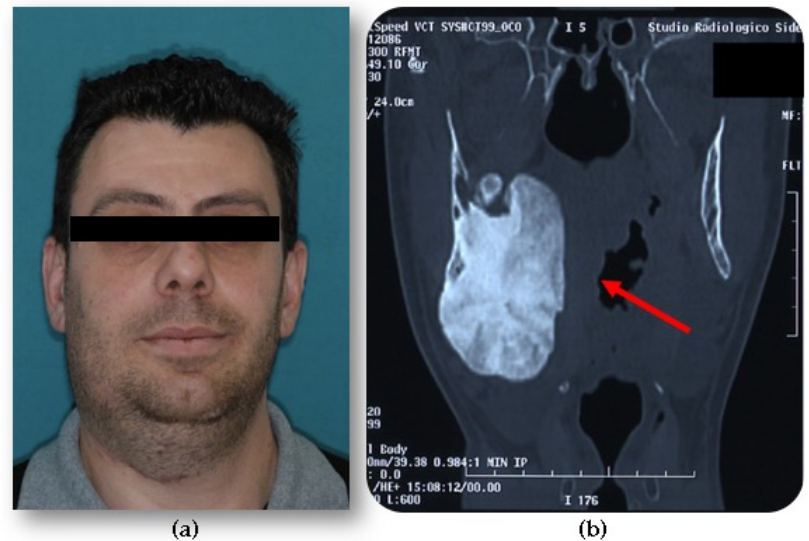
Figure 4. ( a ) A young male affected by an extensive right mandibular osteoma, causing facial swelling. ( b ) Computed tomography (CT) scan shows diffuse enlargement of the entire right mandible, extending to the lateral and medial sides and causing deformation of the pharyngeal walls.